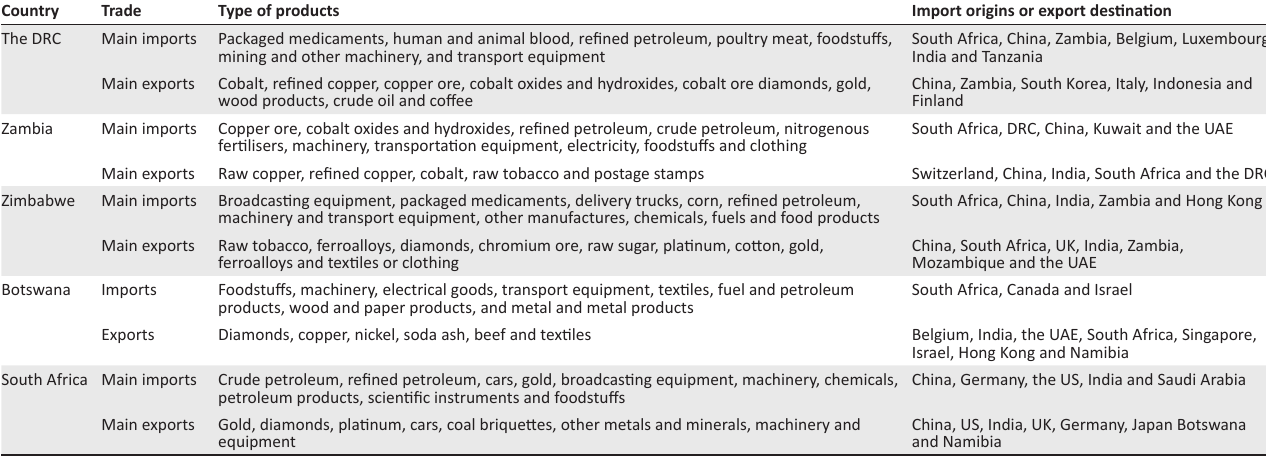
TABLE 1: Main regional import and export commodities for the North–South Corridor economies as of December 2017.